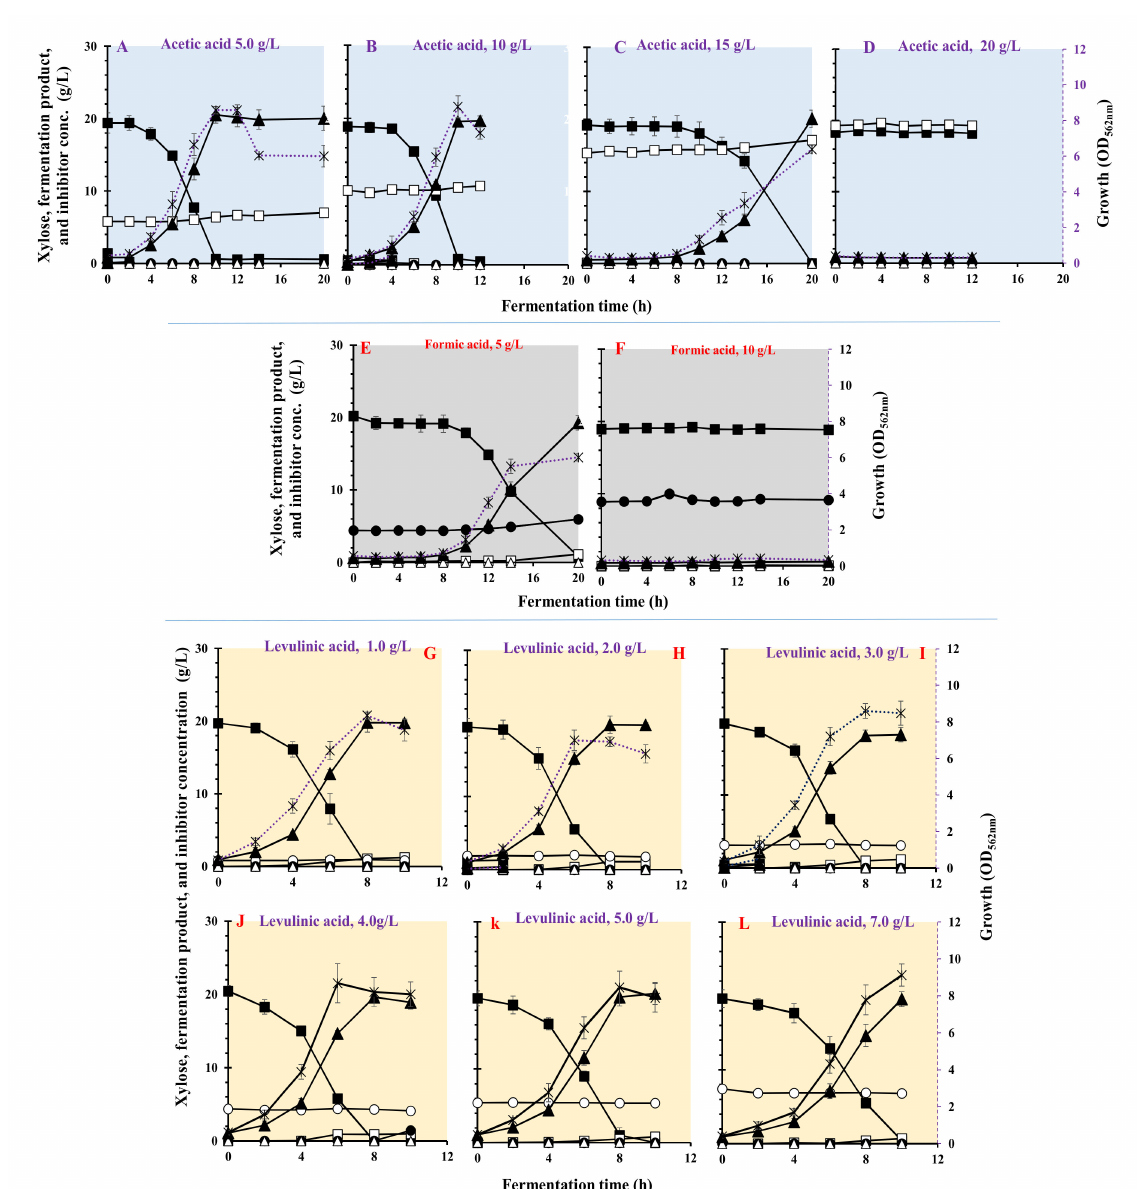
Figure 2. Effect of different concentrations of acetic acid ( A – D ), formic acid ( E , F ), and levulinic acid ( G – L ) on the growth and lactic acid production by Bacillus coagulans Azu-10. Symbols: (cid:4) , xylose (g/L); (cid:3) , acetic acid (g/L); acid, formic acid, or levulinic acid, g/L); • , formic acid (g/L); ∆ , ethanol (g/L); (cid:78) , lactic acid (g/L); *, growth (OD 562nm ). The standard deviation is less than the size of symbols if no error bars are